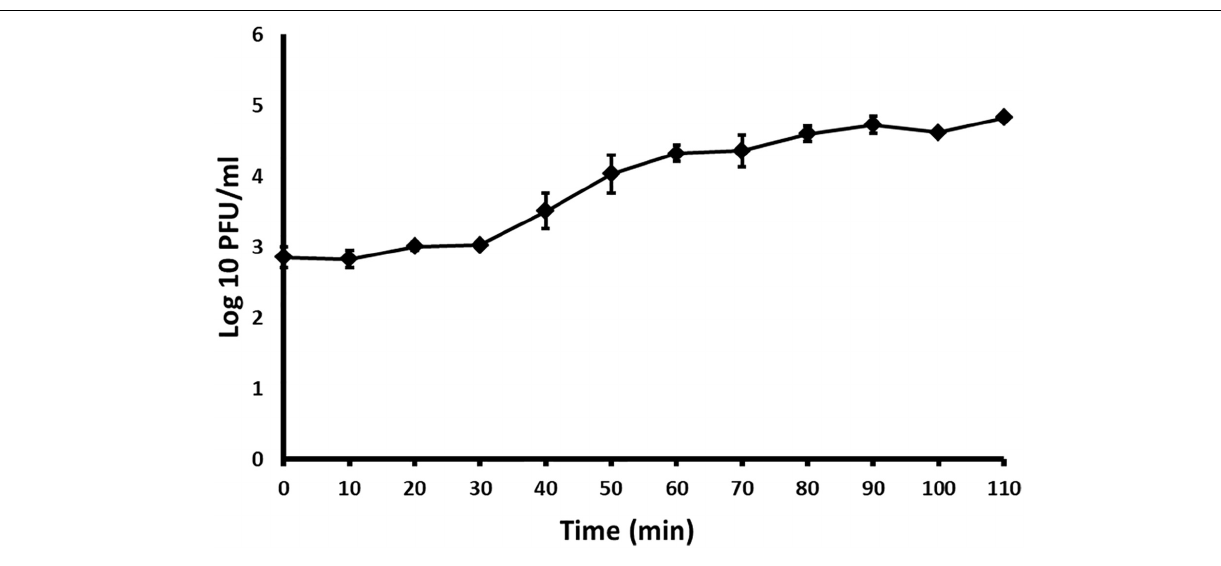
( Figure 7 ). Length of ORFs ranges from 117 to 4077 bp, encoding putative proteins of 38–1358 amino acids. Total of 92.3% of the genome consists of coding regions. Among all identified ORFs, 74 start with ATG as the start codon while 14 start with GTG and one with TTG codon. The orientation of genome annotation showed that 45 genes are on the plus strand, while 44 on the reverse strand. Out of 89 putative ORFs, 20 (22.5%) have an assigned function, while the rest of 73 ORFs (77.5%) were classified as hypothetical or phage proteins ( Supplementary Table 1 and Figure 7 ). Functional grouping of predicted ORFs revealed that nine ORFs encode